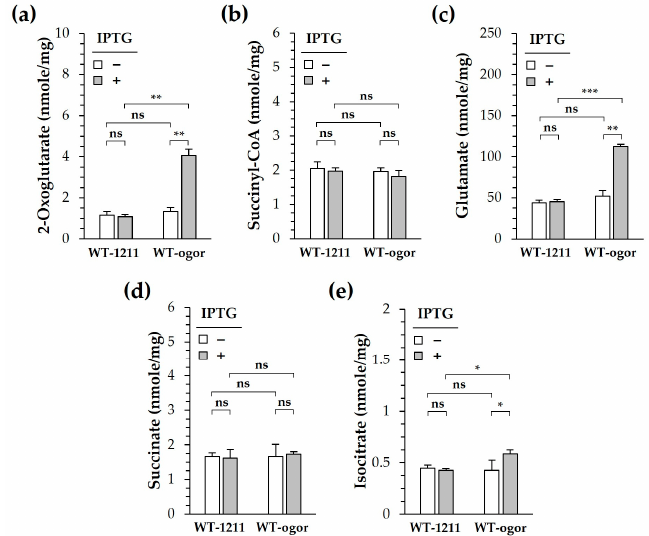
Figure 6. Cellular metabolite levels of Synechocystis producing 2-oxoglutarate:ferredoxin oxidoreductase (CtOGOR). WT-ogor and WT-1211 were grown photoautotrophically in the presence and absence of 1 mM IPTG. Cells were harvested at the exponential phase for metabolite analysis. The cellular level of 2-oxoglutarate ( a ), succinyl-CoA ( b ), glutamate ( c ), succinate ( d ) and isocitrate ( e ) were determined and normalized by total protein contents in the cells (mg). Significances were assessed by Student’s t -test: ns, p > 0.05; *, p ≤ 0.05; **, p ≤ 0.01; ***, p ≤ 0.001 ( n = 3).